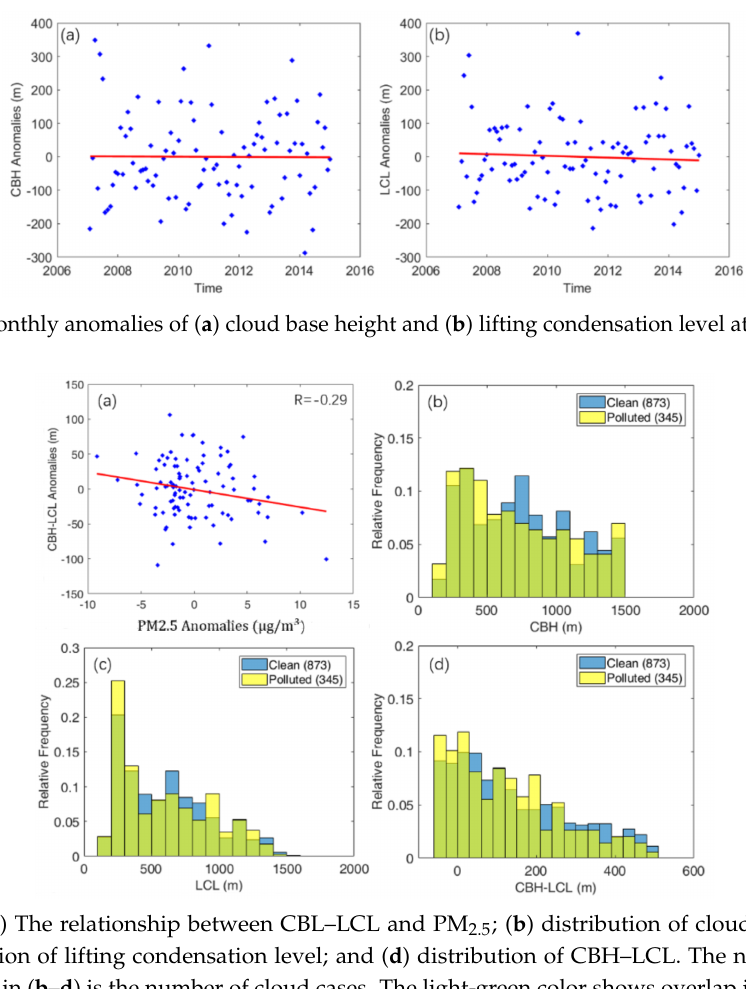
Figure 6. Monthly anomalies of ( a ) PM 2.5 and ( b ) CBH–LCL at LaGuardia International Airport (LGA) station.